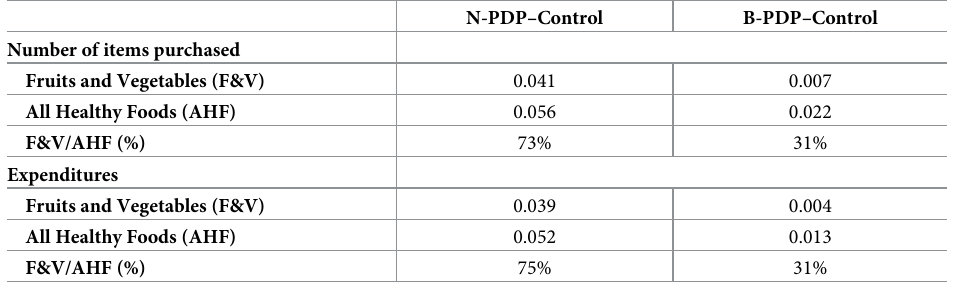
Table 3. Increase in proportion of all healthy foods and fruits and vegetables purchased in N-PDP and B-PDP rel- ative to